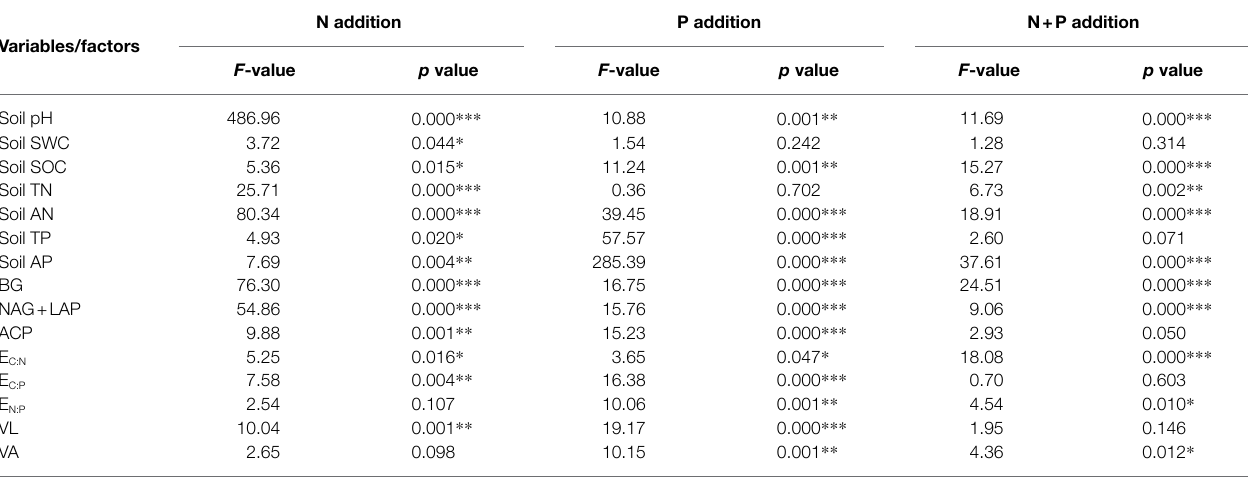
TABLE 1 | Two-way ANOVA of the effects of simulated nitrogen (N) deposition and phosphorus (P) addition on soil nutrient concentration, soil enzyme activity, and soil enzyme stoichiometry of Chinese fir. N Variables/factors